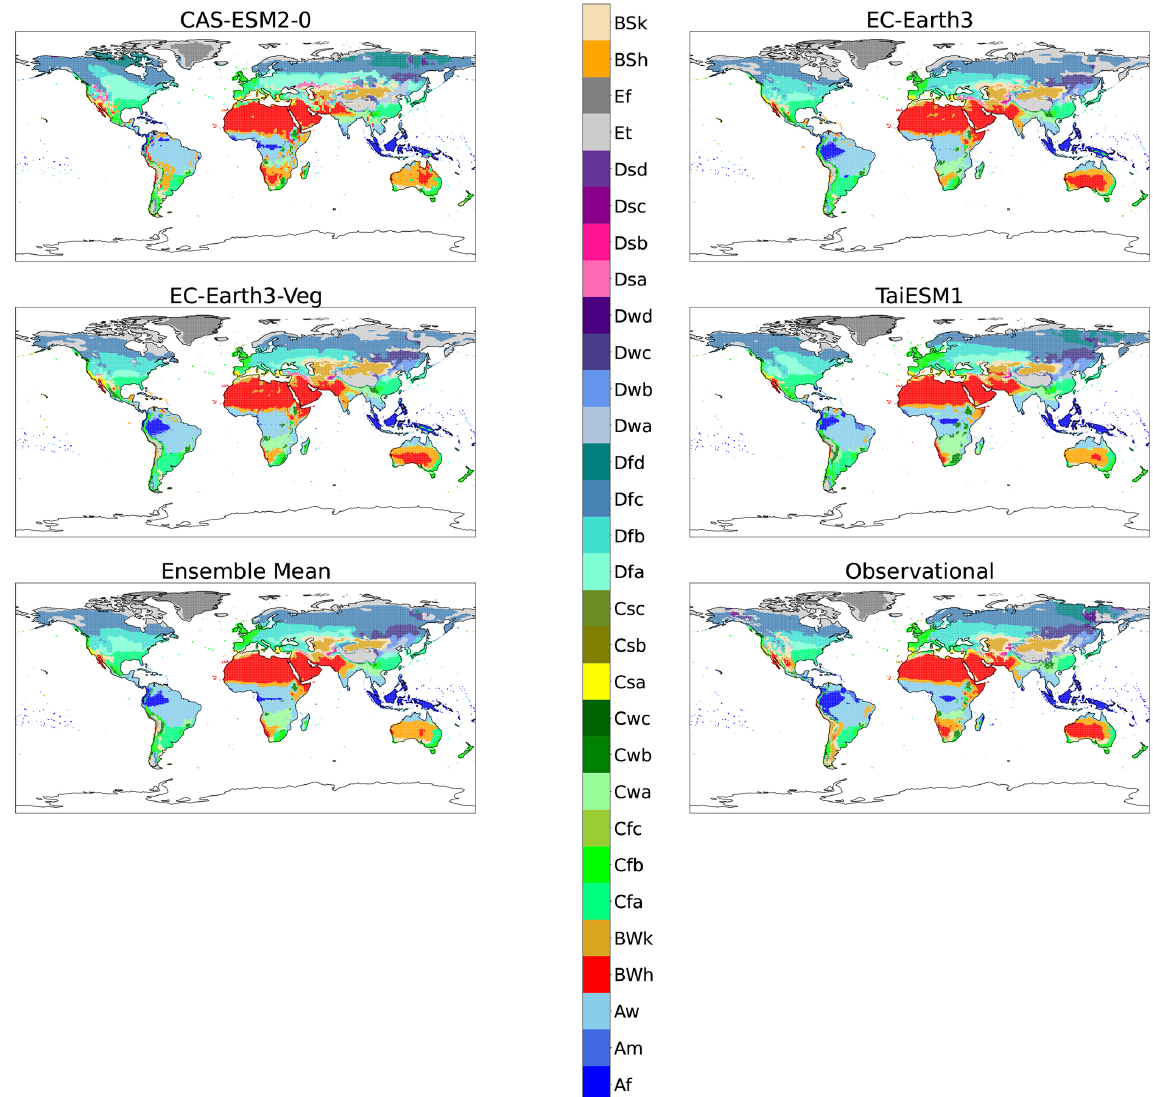
Figure A1. Maps of KG classifications for each model for the reference period (1901–1931) without anomaly